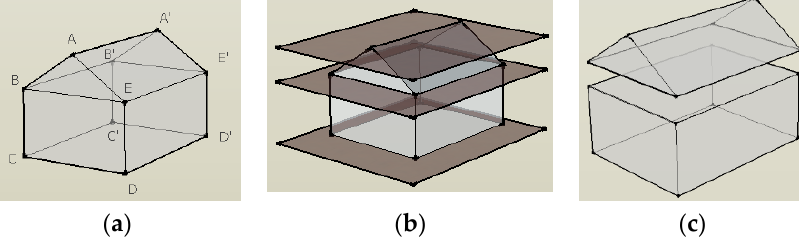
Figure 5. ( a ) Original building stored as an exterior shell model; ( b ) cross-sections; and ( c ) CSG representation using a box and a triangular prism.